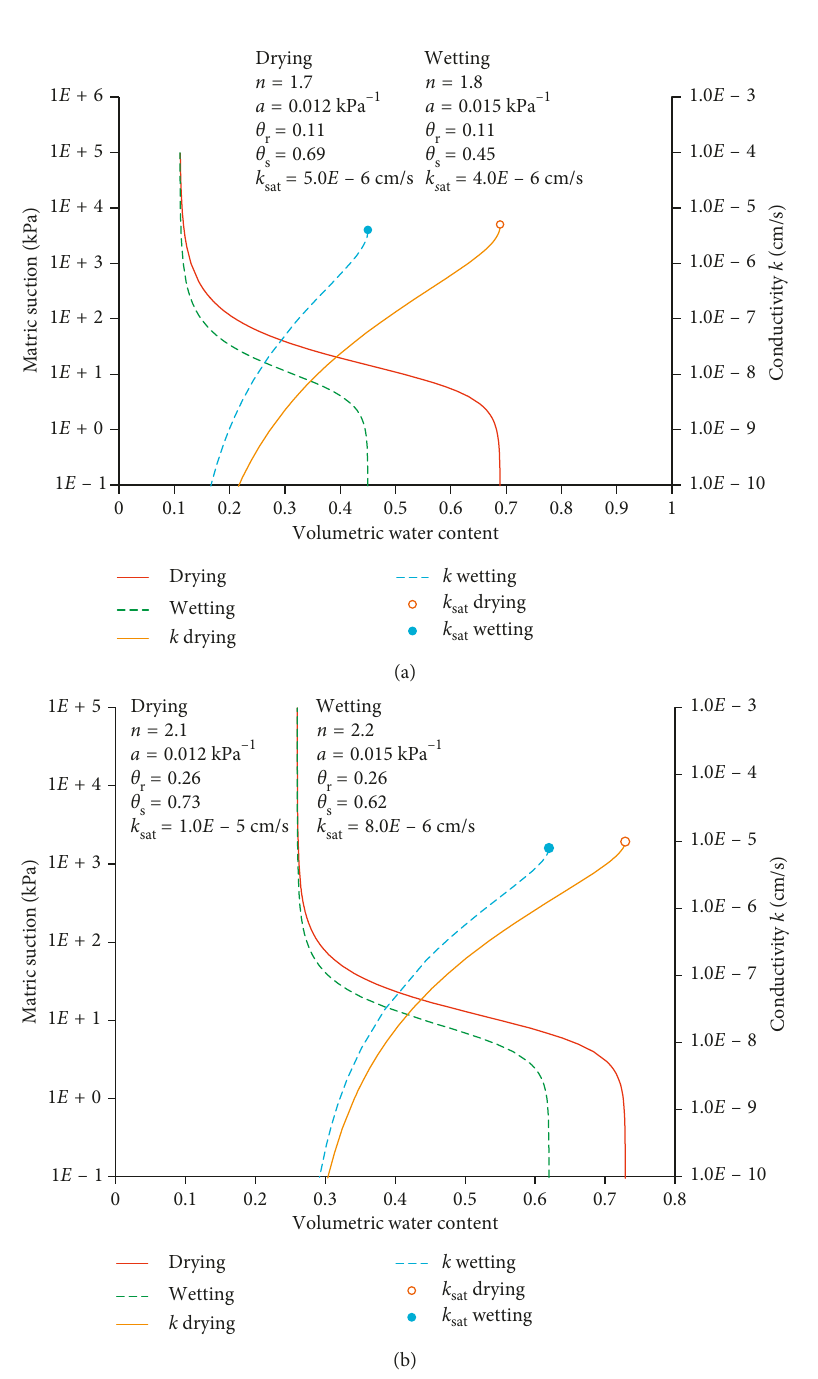
Figure 8: Hydraulic characteristic curves of red mud under moisture desorption-moisture absorption hydraulic path conditions: (a) Bayer red mud and (b) sintering red